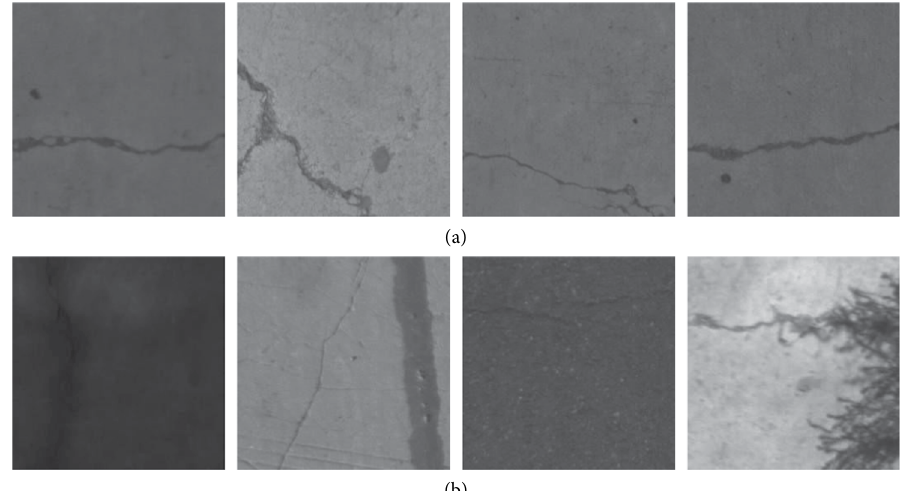
Figure 1: Crack detection challenges. (a) The crack images in the ideal case. (b) Poor lighting conditions, stains, small cracks, and the occlusion of branches increase the difficulty of crack